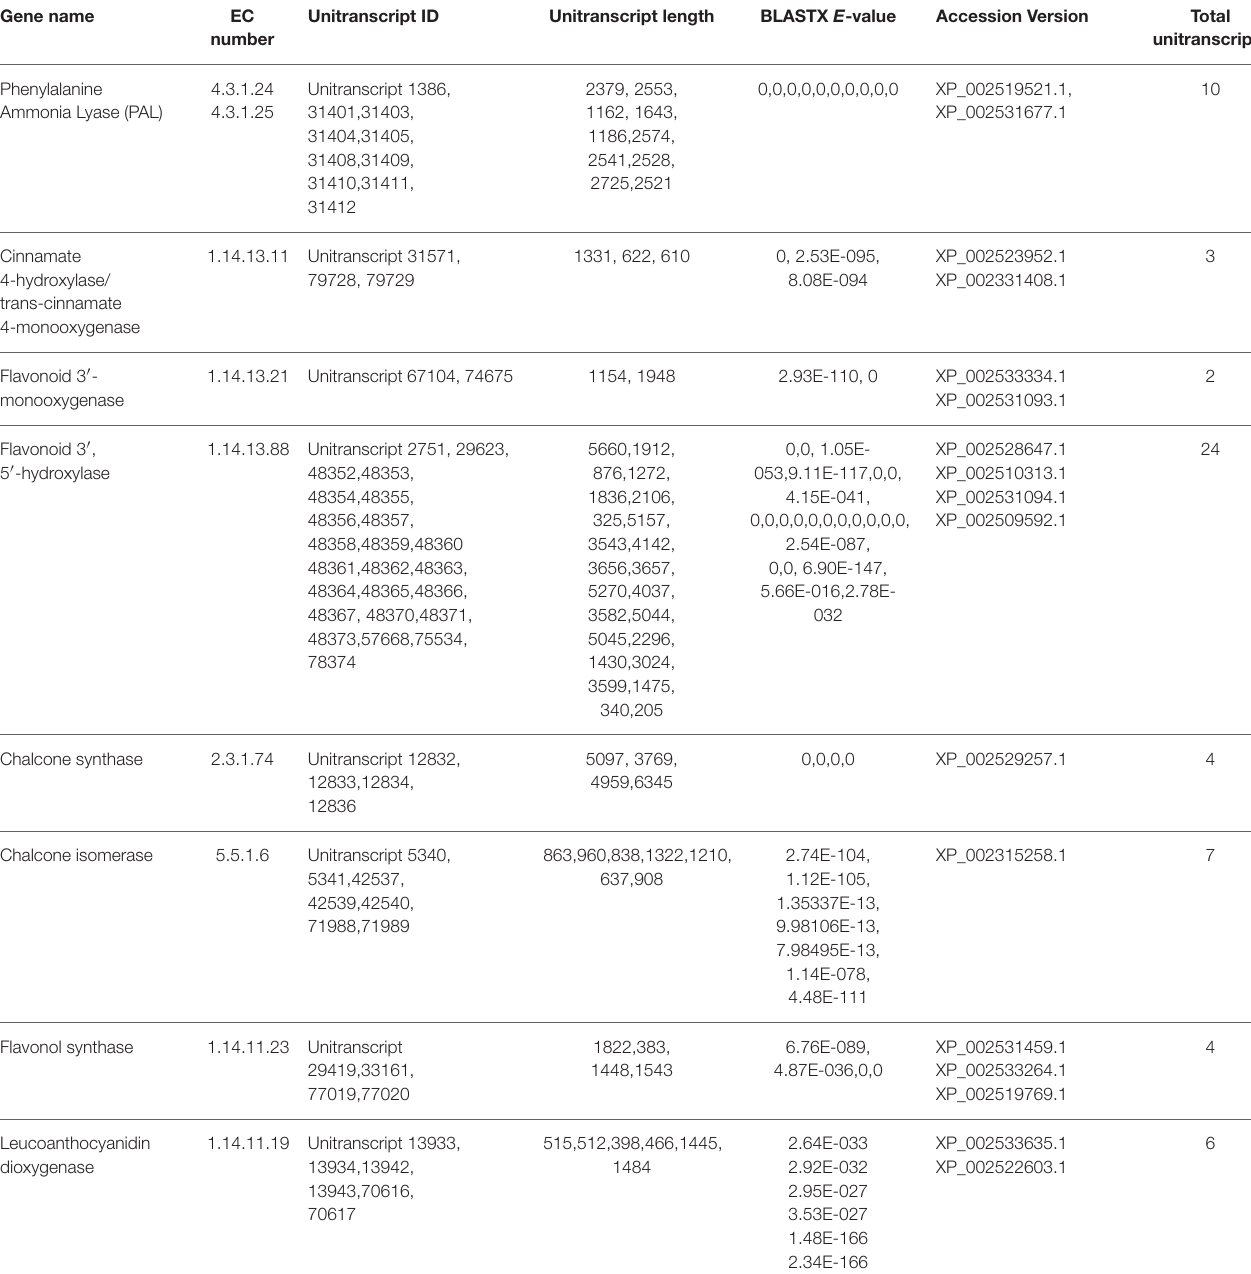
TABLE 1 | Summary of few major genes involved in Phenylpropanoid and Flavonoid biosynthesis pathways identified putatively from P. amarus leaf